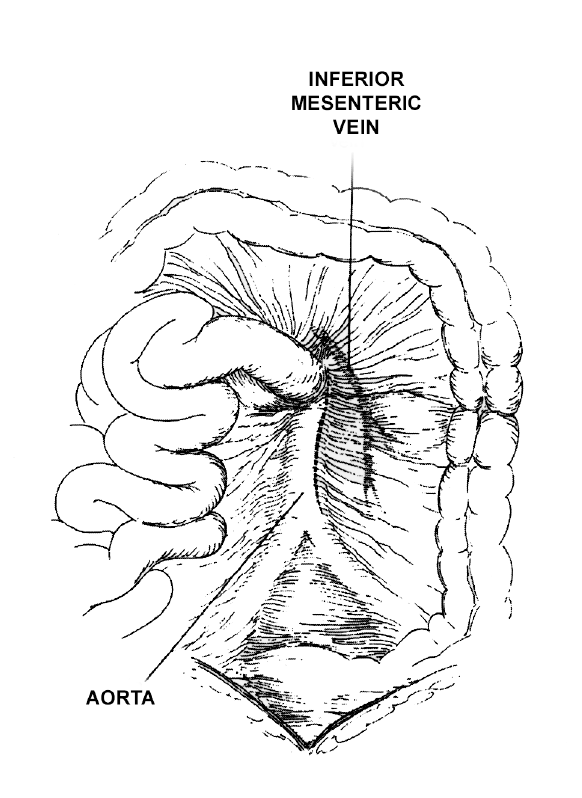
Figure 2 - Surgical approach to the renal vessels and kidney.